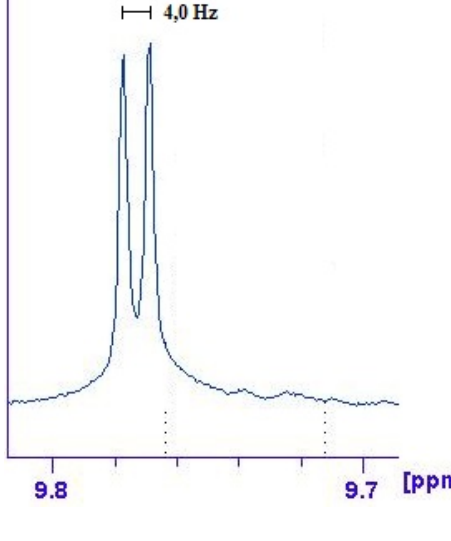
Figure 7. Expanded section of the 1 H-NMR spectrum of complex 14 , focused on the area assigned to proton 6 of 5-aza[5]helicene molecule. A coupling constant of 4 Hz, absent in the spectrum of the free molecule, can be